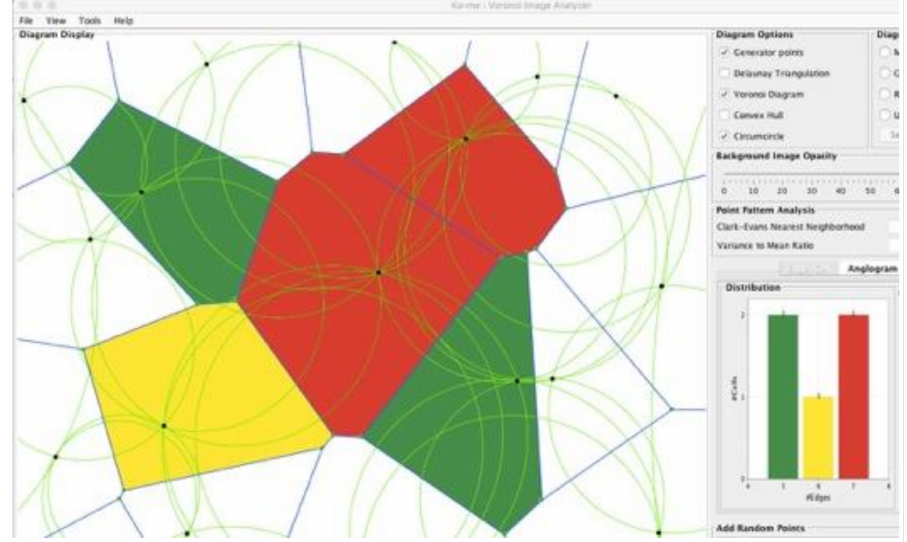
Figure 4. A Voronoi tessellation was generated in Ka-me with random points and the circumcircles are overlaid. Note that each circumcircle has three adjacent Voronoi polygons’ generator points and the center of each circumcircle is the vertex shared by all three adjacent Voronoi